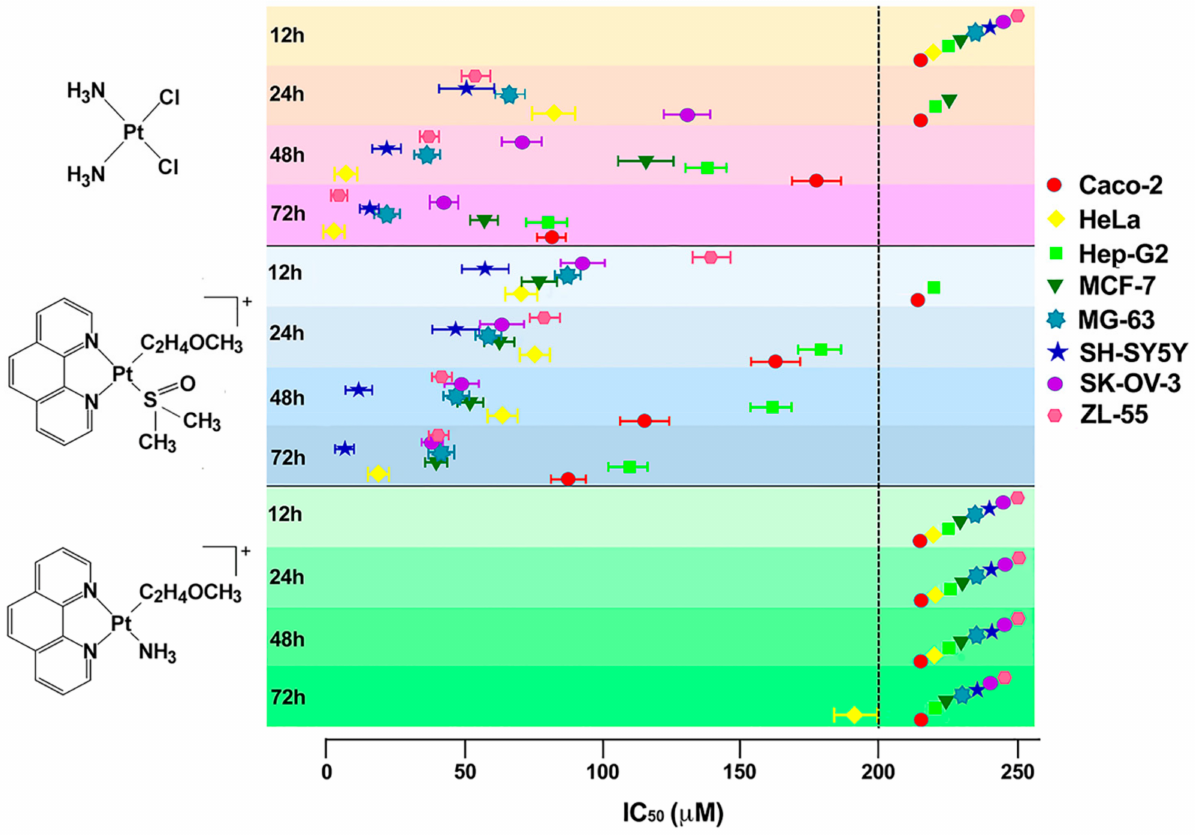
Figure 3. IC 50 after 12, 24, and 48 h of treatment with [Pt( η 1 -C 2 H 4 OMe)(DMSO)(phen)] + , [Pt( η 1 -C 2 H 4 OMe)(NH 3 )(phen)] + and cisplatin at different concentrations (0.1, 1, 10, 100, and 200 µ M) obtained in different human cancer cell